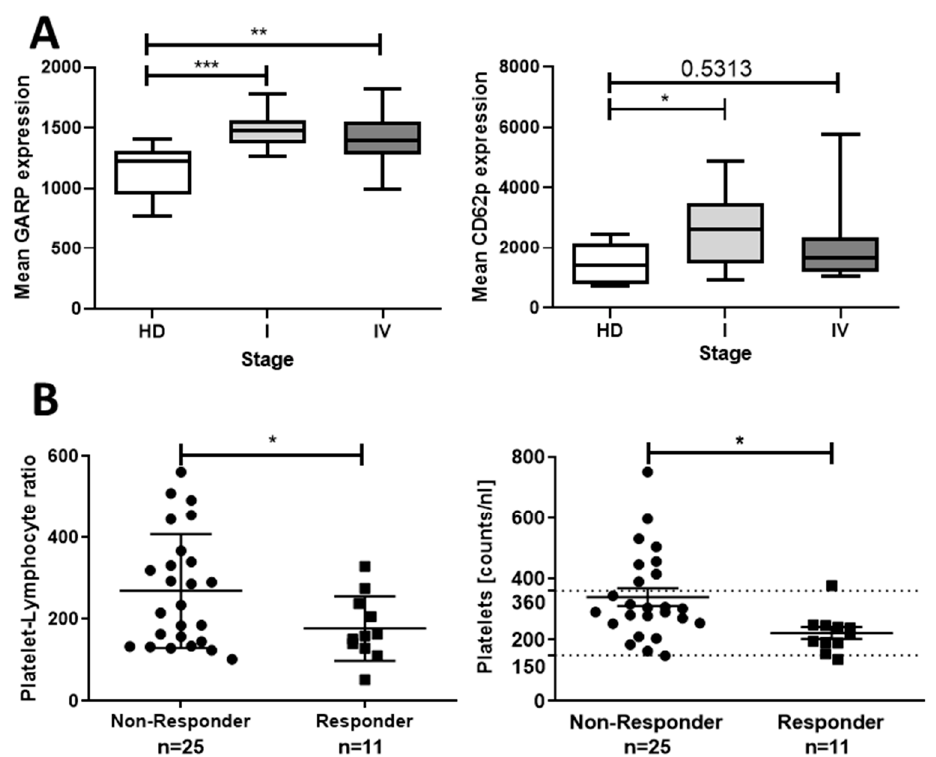
Figure 8. Increased platelet surface GARP levels in stage I / IV melanoma patient stage. ( A ) Comparison of platelet GARP and CD62P surface levels between HD ( n = 8), stage I ( n = 18), and stage IV ( n = 17) melanoma patients assessed via flow cytometry. Means for GARP expression for HD = 1161, stage I = 1489, and stage IV = 1418. Means for CD62P expression are HD = 1470, stage I = 2611, and stage IV = 1977 (box and whiskers, medians ± min / max, * p < 0.05, ** p < .01, *** p < .001, and n.s. determined by unpaired t -test). ( B ) The platelet count in melanoma patients before starting immunotherapy using checkpoint inhibitors was measured as part of the routine blood tests. Platelet counts and the platelet–lymphocyte ratios of non-responders ( n = 25) and responders ( n = 11; staging results after 6 months of therapy) were compared. Means of platelet counts (PC) and the platelet–lymphocyte ratio (PLR) were as follows: progression: PC = 339.8, PLR = 269.0; stable disease: PC = 222.3, PLR = 177.5 (means ± SD, * p < 0.05, ** p ≤ 0.01, *** p ≤ 0.001, and n.s. determined by unpaired t -